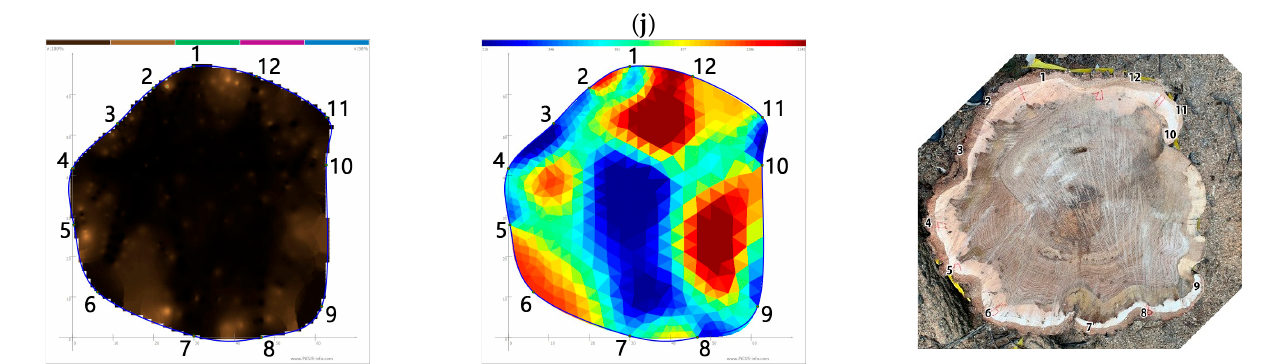
Figure 1. Comparison of the SoT/ERT tomograms and the tree cross-section (the dotted red lines indicate the decayed area. In the SoT tomograms—brown: healthy wood, red and blue: defects, green: initial decays; in the ERT tomograms—blue: high water content, red: lower water content, green and yellow: decreasing water content. ( a ) – ( j ): wood section ID). Table 3. Comparison of the SoT tomograms and wood sections of the compromised wood areas.